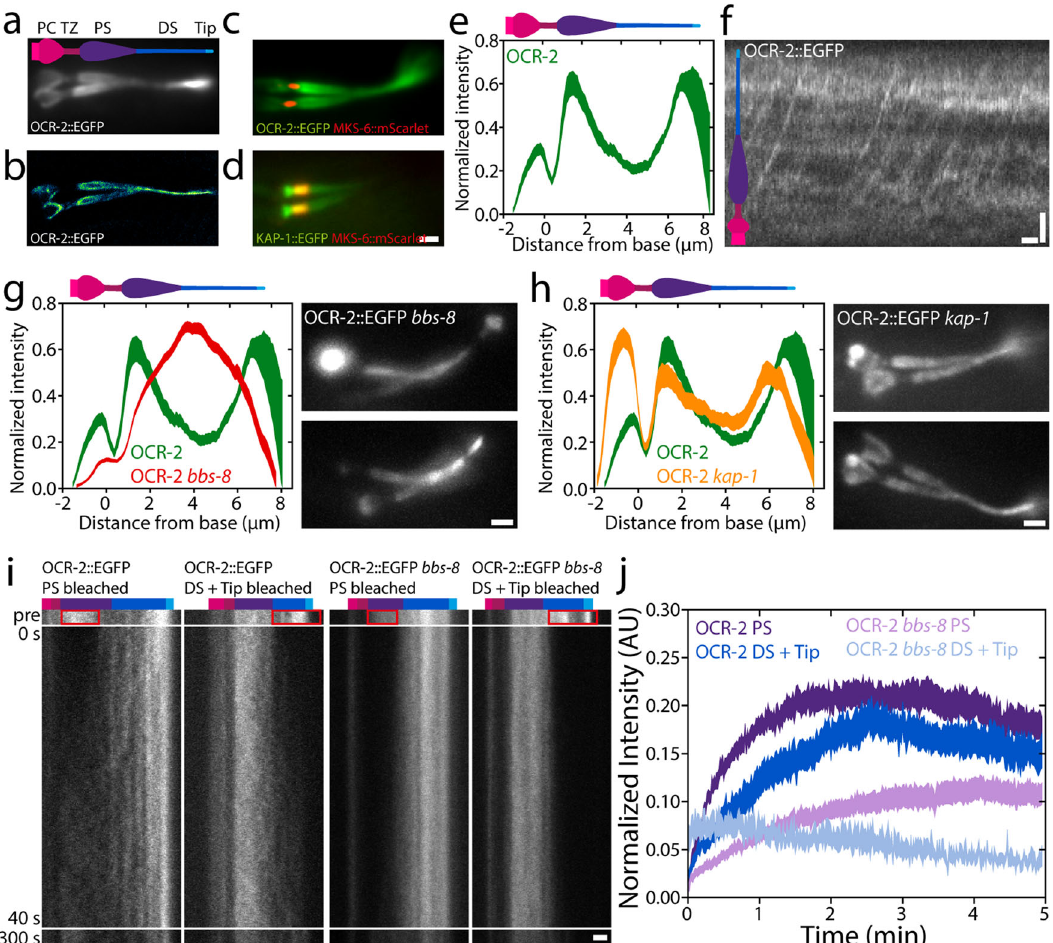
Fig. 1 Ensemble distribution and dynamics of OCR-2. a Time-averaged (over 3 s) fl uorescence images of OCR-2::EGFP. b Super-resolution image of OCR- 2::EGFP molecule localizations. c Dual-color image of endogenously labeled OCR-2::EGFP and overexpressed MKS-6::mScarlet. d Dual-color image of endogenously labeled Kinesin-II(KAP-1::EGFP) and MKS-6::mCherry. Scale bar: 1 μ m. e Average intensity distribution of OCR-2::EGFP along the cilium ( n = 22 cilia, averaged normalized intensity distributions). f Kymograph of ensemble dynamics of OCR-2::EGFP with bars indicating the PS (purple) and DS (dark blue). Scale bars: 1 μ m and 1 s. g Left: averaged normalized average intensity distribution of OCR-2::EGFP (green) and OCR-2::EGFP bbs-8 (red) ( n = 71) along the cilium. Right: Time-averaged fl uorescence images of OCR-2::EGFP bbs-8 . Scale bar: 1 μ m. h Left: normalized average ciliary distribution of OCR-2::EGFP (green; same data as e ) and OCR-2::EGFP, kap-1 mutant (red) ( n = 26 worms). Right: Time-averaged (over 3 s) fl uorescence images of OCR- 2::EGFP, kap-1 mutant. Scale bar: 1 μ m. i Representative kymographs before and after photobleaching the PS, or DS and Tip of OCR-2::EGFP and